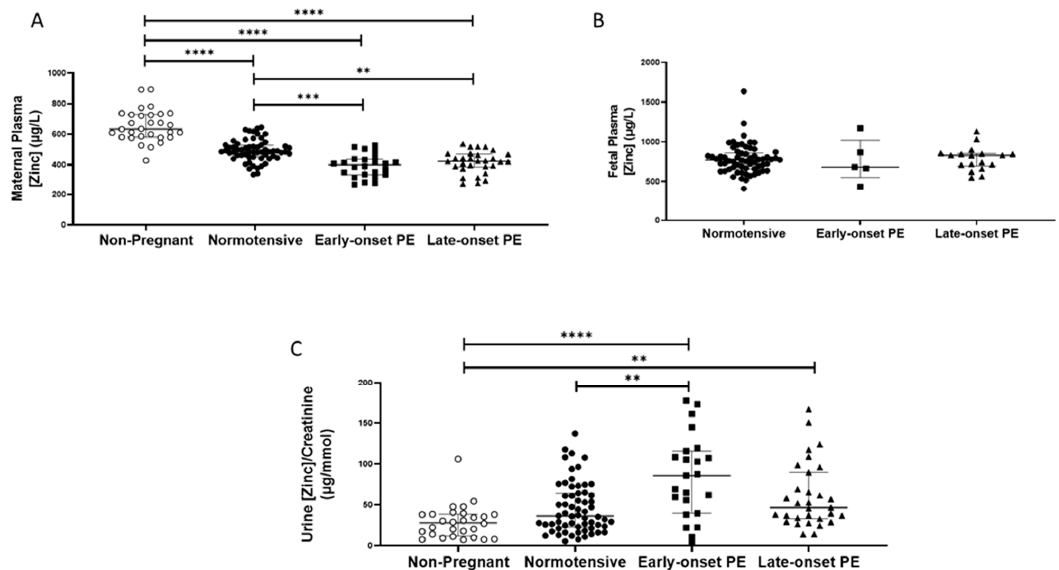
Figure 2. ( A ) Maternal plasma zinc concentrations in non-pregnant (n = 30) and normotensive pregnant women (n = 60) and those with early- (n = 24) and late-onset (n = 31) pre-eclampsia (PE); ( B ) umbilical cord venous (fetal) plasma zinc concentrations in normotensive pregnant women (n = 60) and those with early- (n = 5) and late-onset (n = 18) PE; ( C ) Urinary zinc/creatinine concentrations in non-pregnant (n = 28), normotensive pregnant (n = 60) and women with early- (n = 23) and late- onset (n = 31) PE. Data presented as median (IQR); ** p < 0.005; *** p < 0.001; **** p < 0.0001. Median urinary zinc/creatinine concentrations were similar in non-pregnant women and normotensive pregnant controls but were considerably lower than in women who had pre-eclampsia ((27.9 (12.0, 38.4), compared with non-pregnant women 57.5 (36.8, 103.9) µg/mmol p < 0.0001). Moreover, higher levels were found in women who had pre- eclampsia, compared to normotensive pregnant women (36.3 (23.2, 64.0); p = 0.003). On splitting the pre-eclampsia group, only women with early-onset pre-eclampsia had higher zinc/creatinine concentrations compared to normotensive pregnant women ( p = 0.009; Figure 2C).